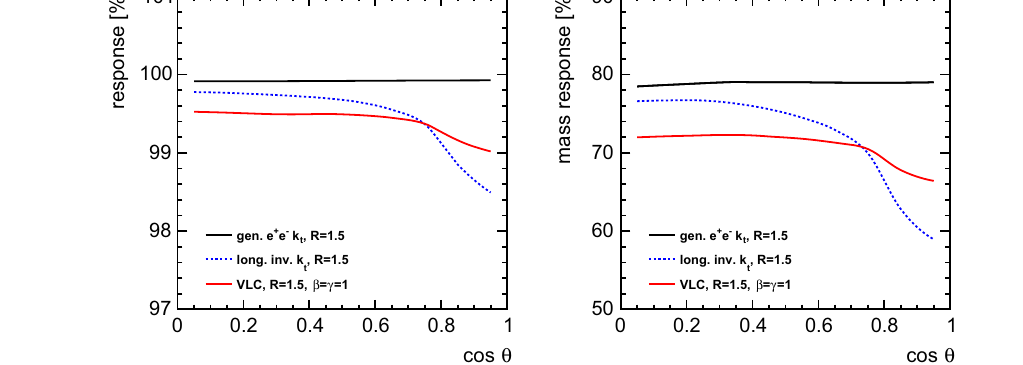
jet mass. Both quantities are normalised to the response of the Durham algorithm: E = 1.5 TeV, m ∼ 370